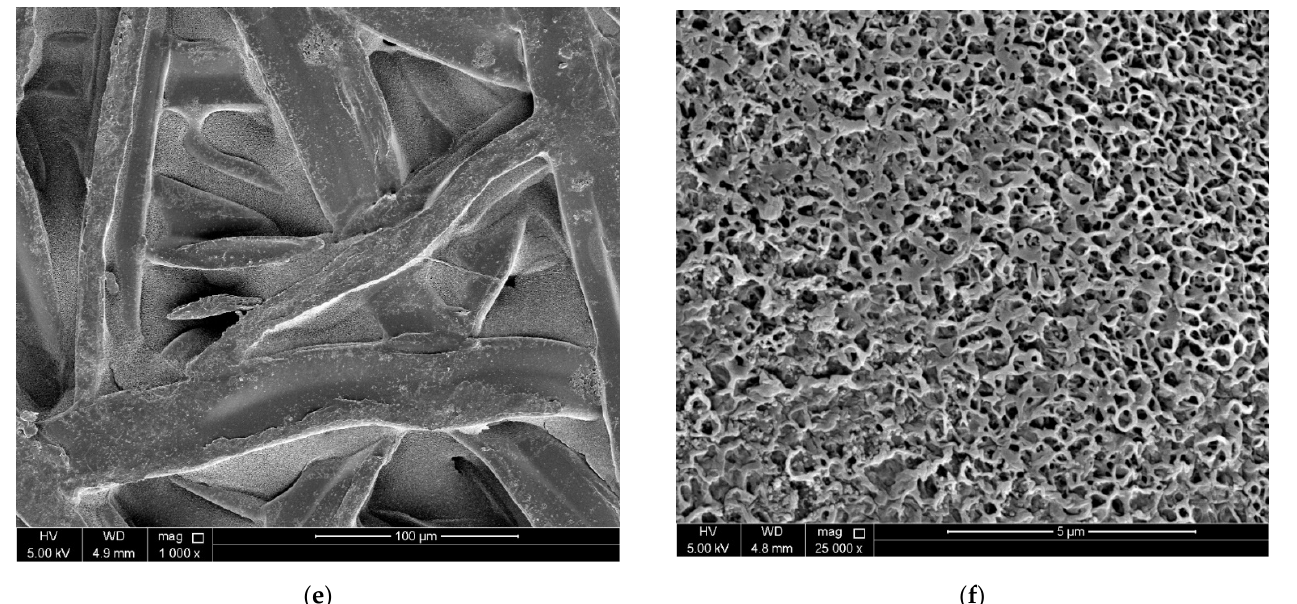
Figure 9. SEM Images of ( a ) nanofiber membrane, ( b ) fiber diameter distribution in the nanofiber membrane, ( c ) top surface view of the pristine TFC at 1000 × magnification, ( d ) top surface view of the pristine TFC at 25,000 × magnification, ( e ) top surface view of 0.05-GQD/PA TFN at 1000 × magnification, ( f ) top surface view of 0.05-GQD/PA TFN at 25,000 × magnification.